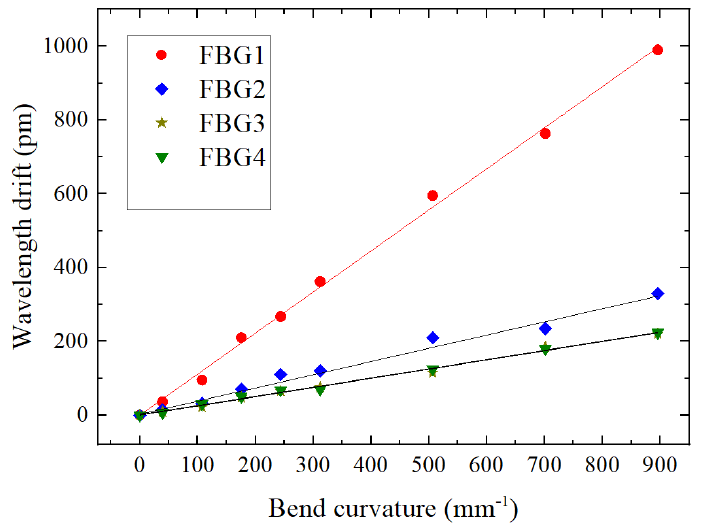
Figure 13. Relationship between bending and wavelength drift of three kinds of FBG